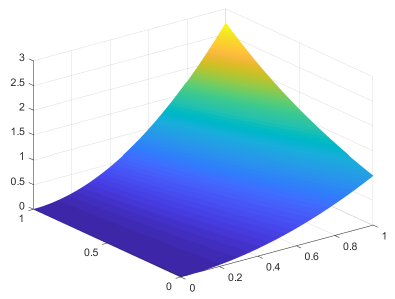
Table 6. Experiment results for the exact solution u = x 2 e y with B.C. V.